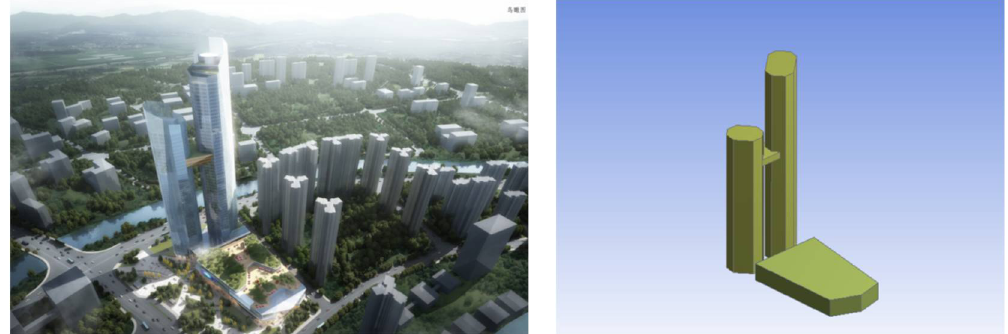
Figure 1. Aerial view of the building.